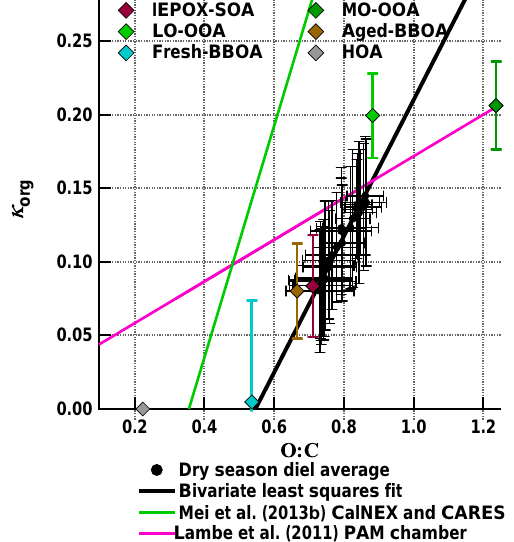
Figure 11. The variation of PMF factor hygroscopicity, 1h diel av- erage of organic hygroscopicity, and O:C ratio at 142 and 171nm for urban pollution air masses. Also shown are the relationships be- tween κ org and O:C reported by earlier field and laboratory studies.